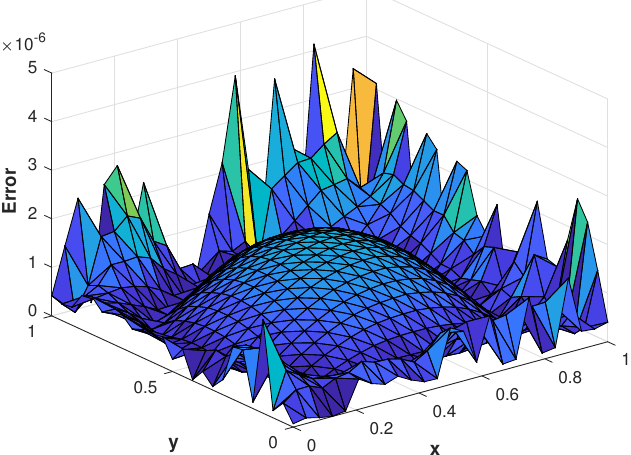
= 625, N S = 18, σ n = 20 at T = 1 G N = 625 , N S = 18 , σ n = 20 at T = 1 G N